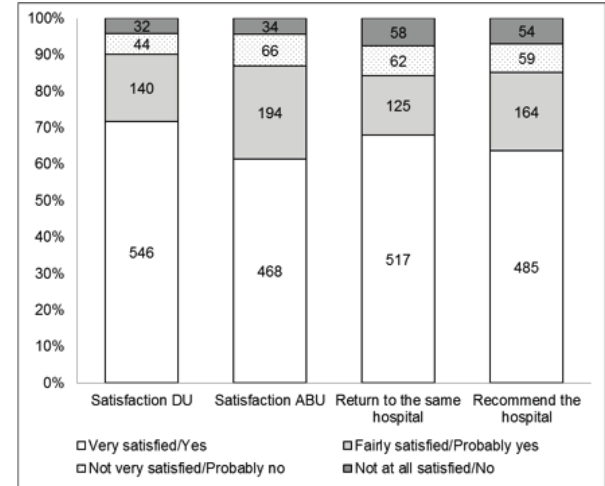
Figure 1 :Frequency of answers to the outcome questions. Number of each answer is